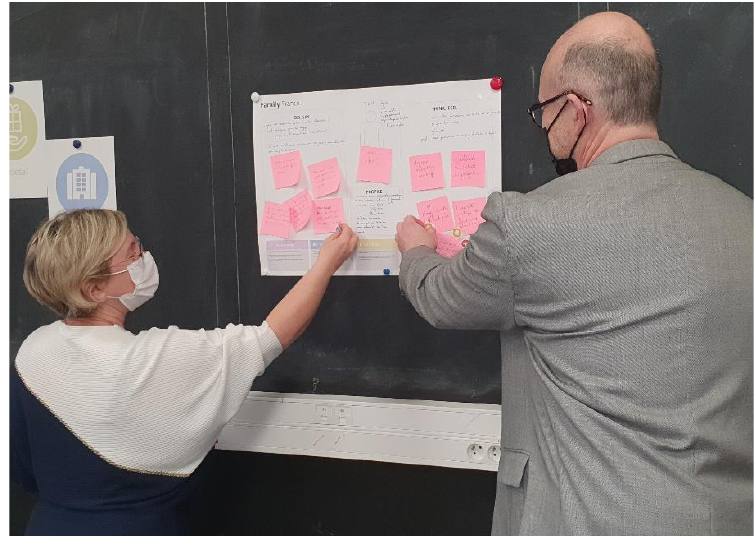
Figure 5. Working with a Needs Empathy Map (Phase II: Empathize).